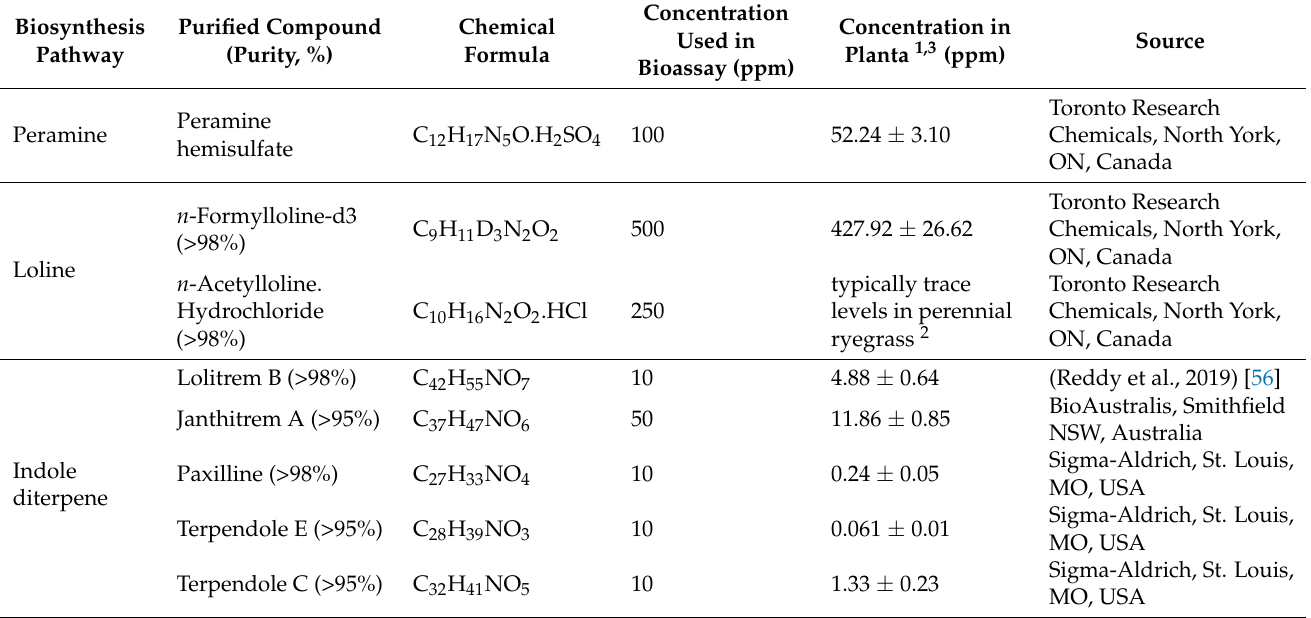
Table 2. Purified compounds and concentrations used in